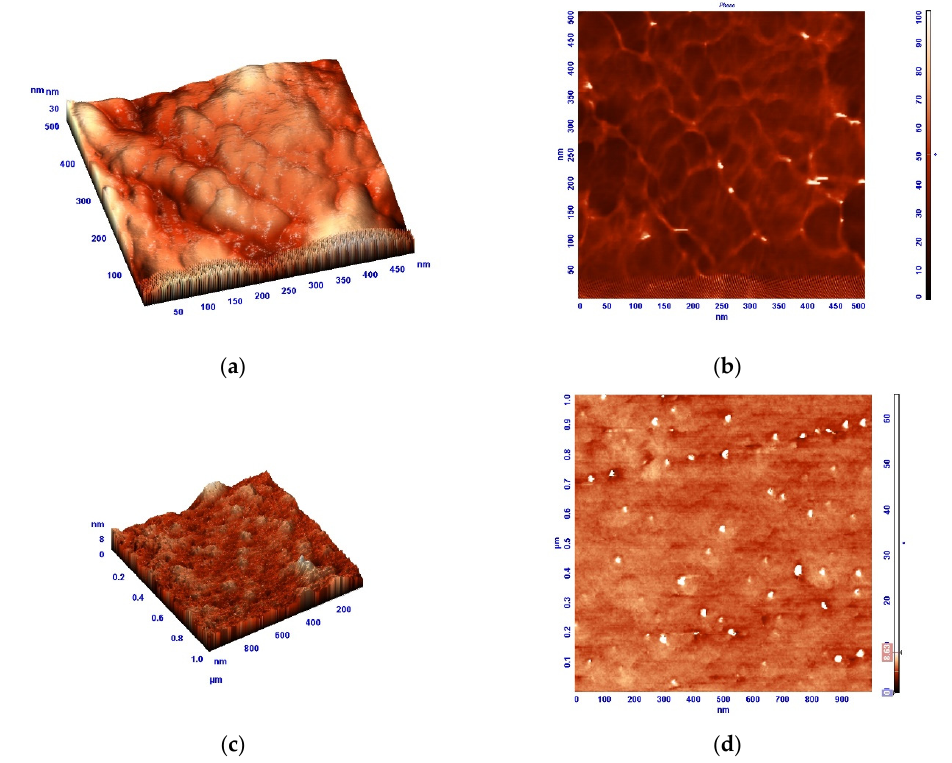
Figure 1. AFM images of upper layers of nonporous dense PAI-1 ( a , b ) and PAI-2 ( c , d ) films ( a , c — 3D images, b , d —images obtained in the phase contrast mode) [8].